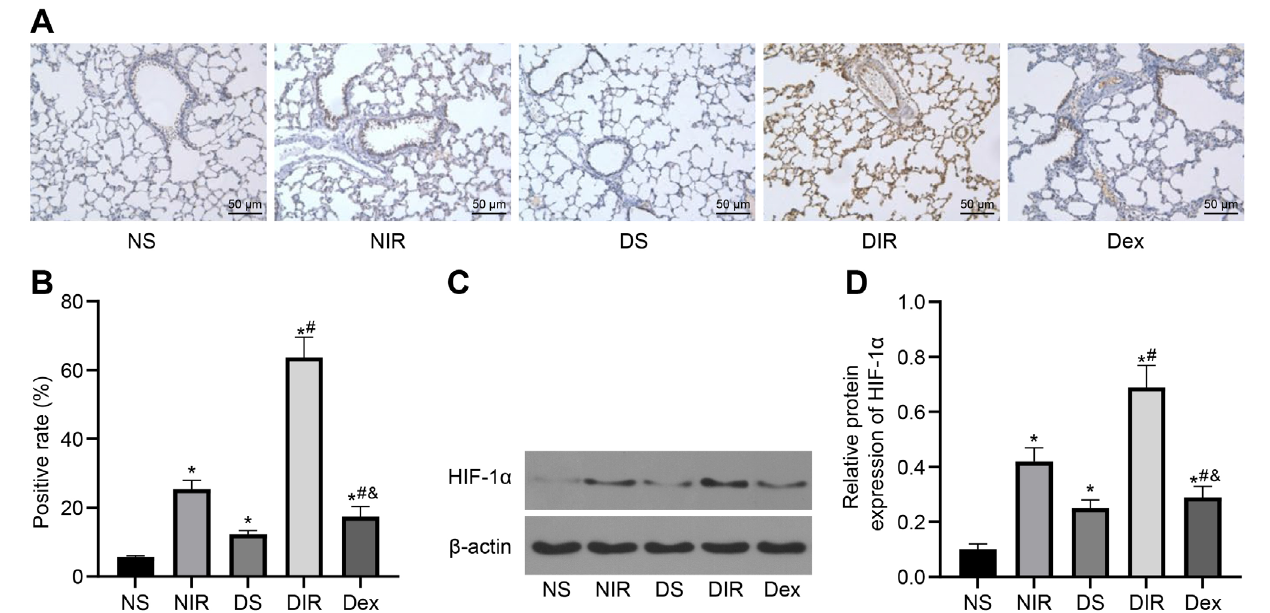
Fig. 5 - Dexmedetomidine (Dex) inhibits hypoxia-inducible factor-1α (HIF-1α) in lung tissues from the diabetic myocardial ischemia/ reperfusion-induced acute lung injury rats. A-B) HIF-1α expression (A) and positive rate (B) in lung tissues from each group after being treated by Dex for four weeks examined by immunohistochemistry. C-D) HIF-1α expression (C) and grey value (D) in lung tissues from each group after being treated by Dex for four weeks tested by western blot analysis. *P<0.05, compared with the non-diabetic sham (NS) group; # P<0.05, compared with the diabetic sham (DS) group; & P<0.05, compared with the diabetic + ischemia/reperfusion (DIR) group. NIR=non-diabetic +